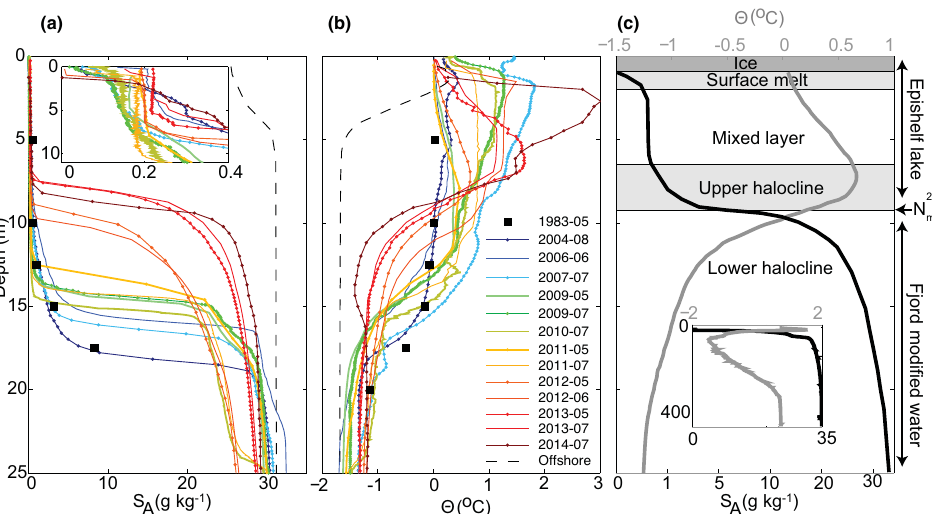
Figure 4. Changes in (a) salinity ( S A ) and (b) temperature ( (cid:50) ) properties of the upper 25m of Milne Fiord from all field campaigns from 1983 to 2014. A single representative profile collected at the mooring site from each field campaign is shown when multiple profiles were collected. Inset in (a) shows a zoom-in of epishelf lake salinities. Dashed lines in (a) and (b) indicate a representative profile collected offshore of the MIS. (c) Idealized salinity (black line) and temperature (grey line) profiles showing the layers of the upper water column. Note the non-linear salinity scale. The epishelf lake is defined as extending from the surface to the buoyancy frequency maximum ( N 2 max ). The inset shows the full water column properties of the fjord to 440m